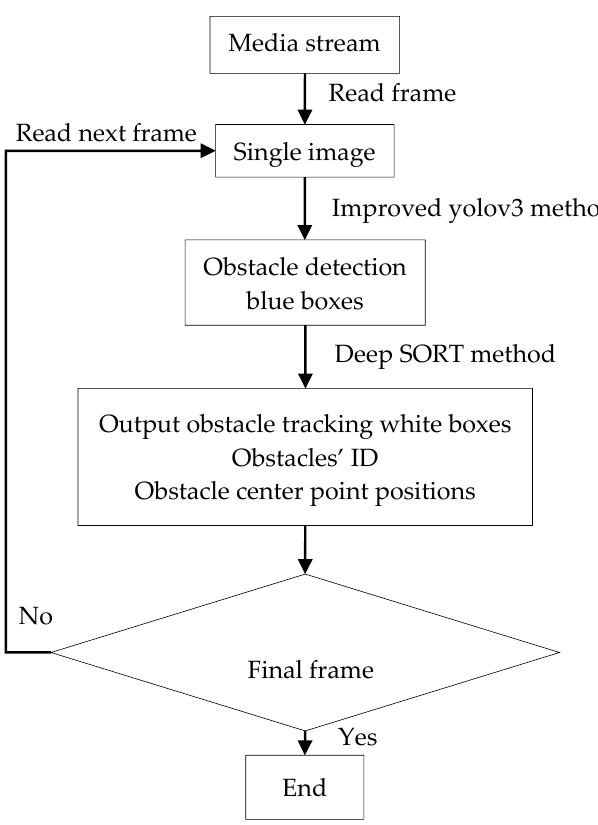
Figure 4. Flowchart of obstacle detecting and tracking.